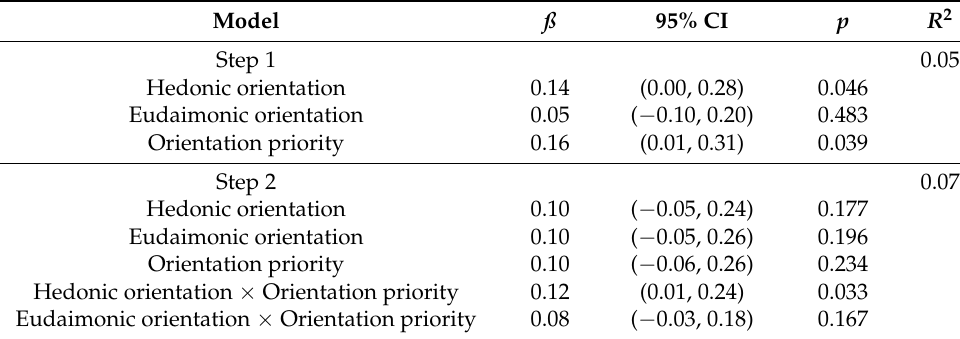
Table 3. Regression results using positive affect as a dependent variable.